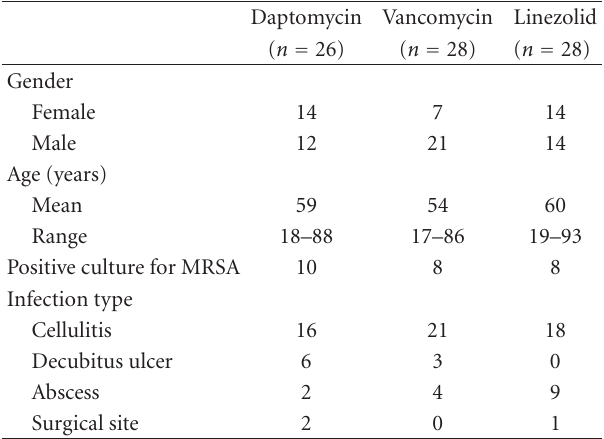
Daptomycin Vancomycin